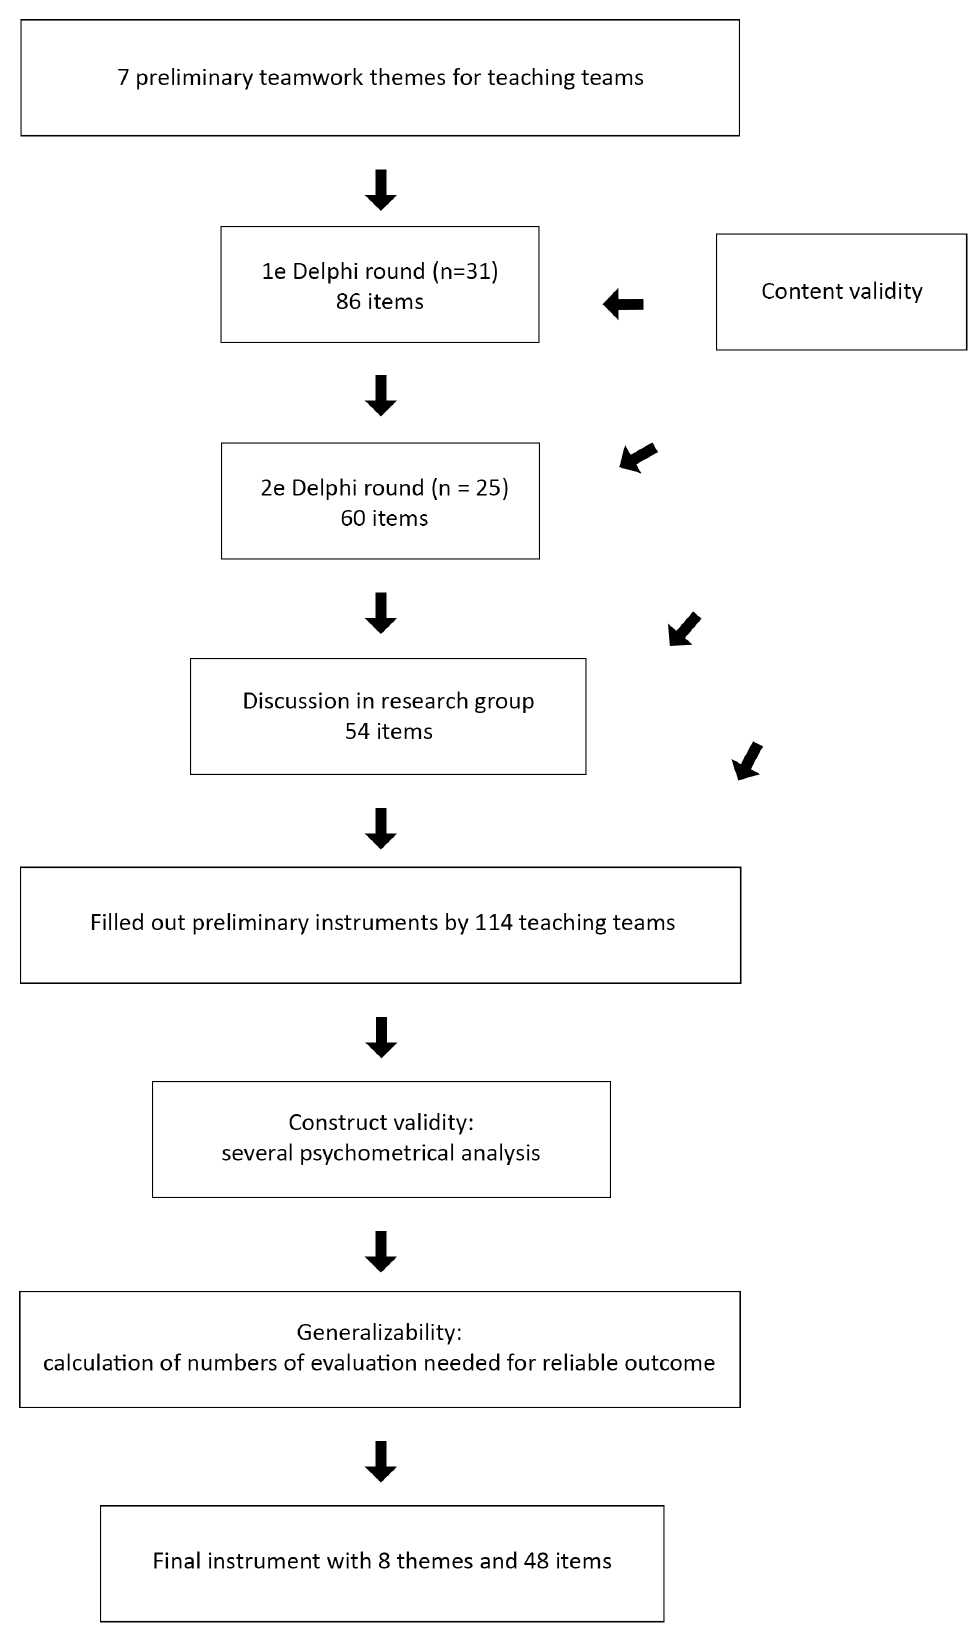
Figure 1. Flowchart of different steps in developing and validating TeamQ measurement instrument. doi:10.1371/journal.pone.0112805.g001 PLOS ONE |